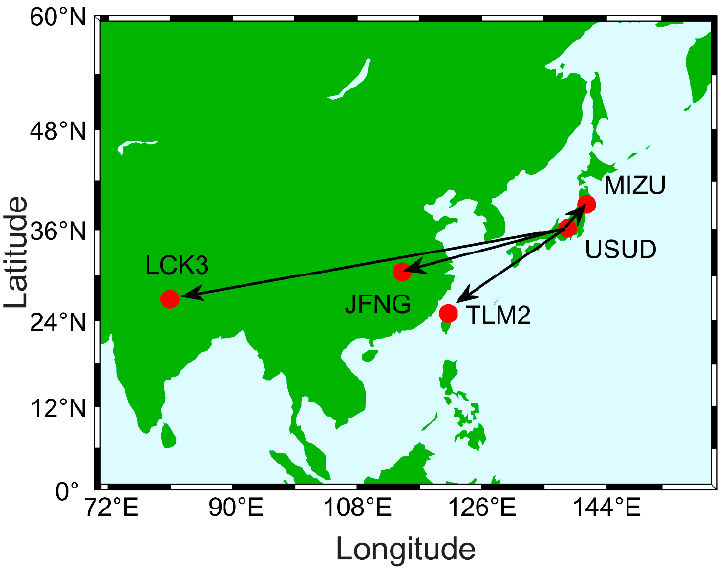
Figure 2. The location of selected stations used for B2b-RTPPP time transfer. Table 2. Information of selected stations.